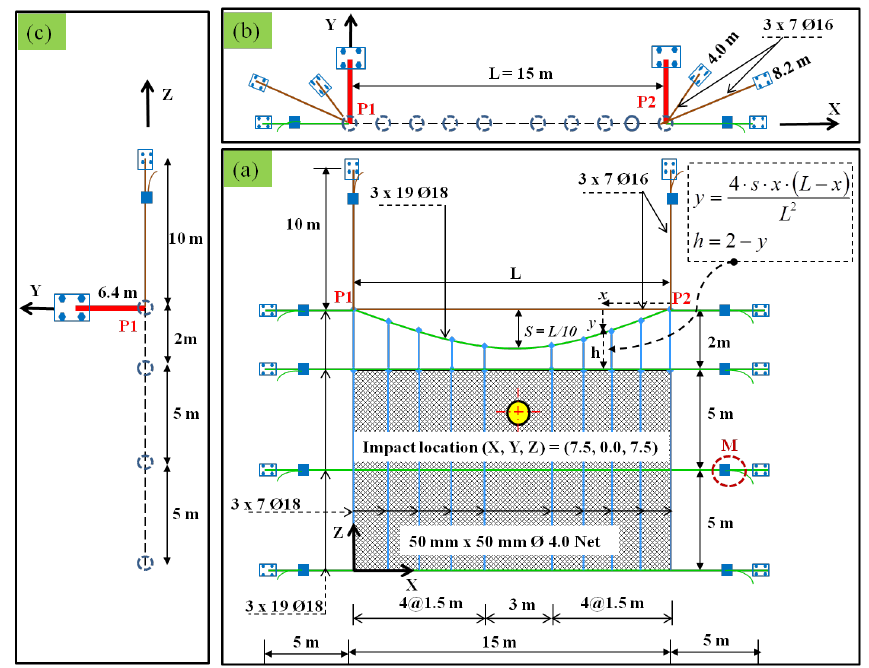
Figure 1. The geometry and composition of the structural model of the R-LPR consisting of the net-cables-dissipators system as major and the idealized/generalized orientation of the support system as minor. (a) Front elevation. (b) Top view. (c) Side elevation viewed from the left towards the end-post P1. The maximum cable tension and the corresponding maximum slip-displacement were recorded at the the location M having been highlighted. See Dhakal et al. (2011a) for more information.